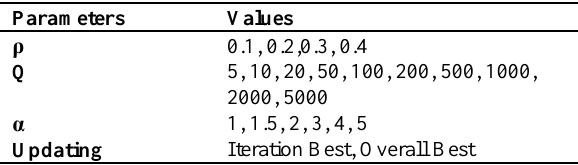
Table 2. Experimented parameter configuration,s and values in experiment